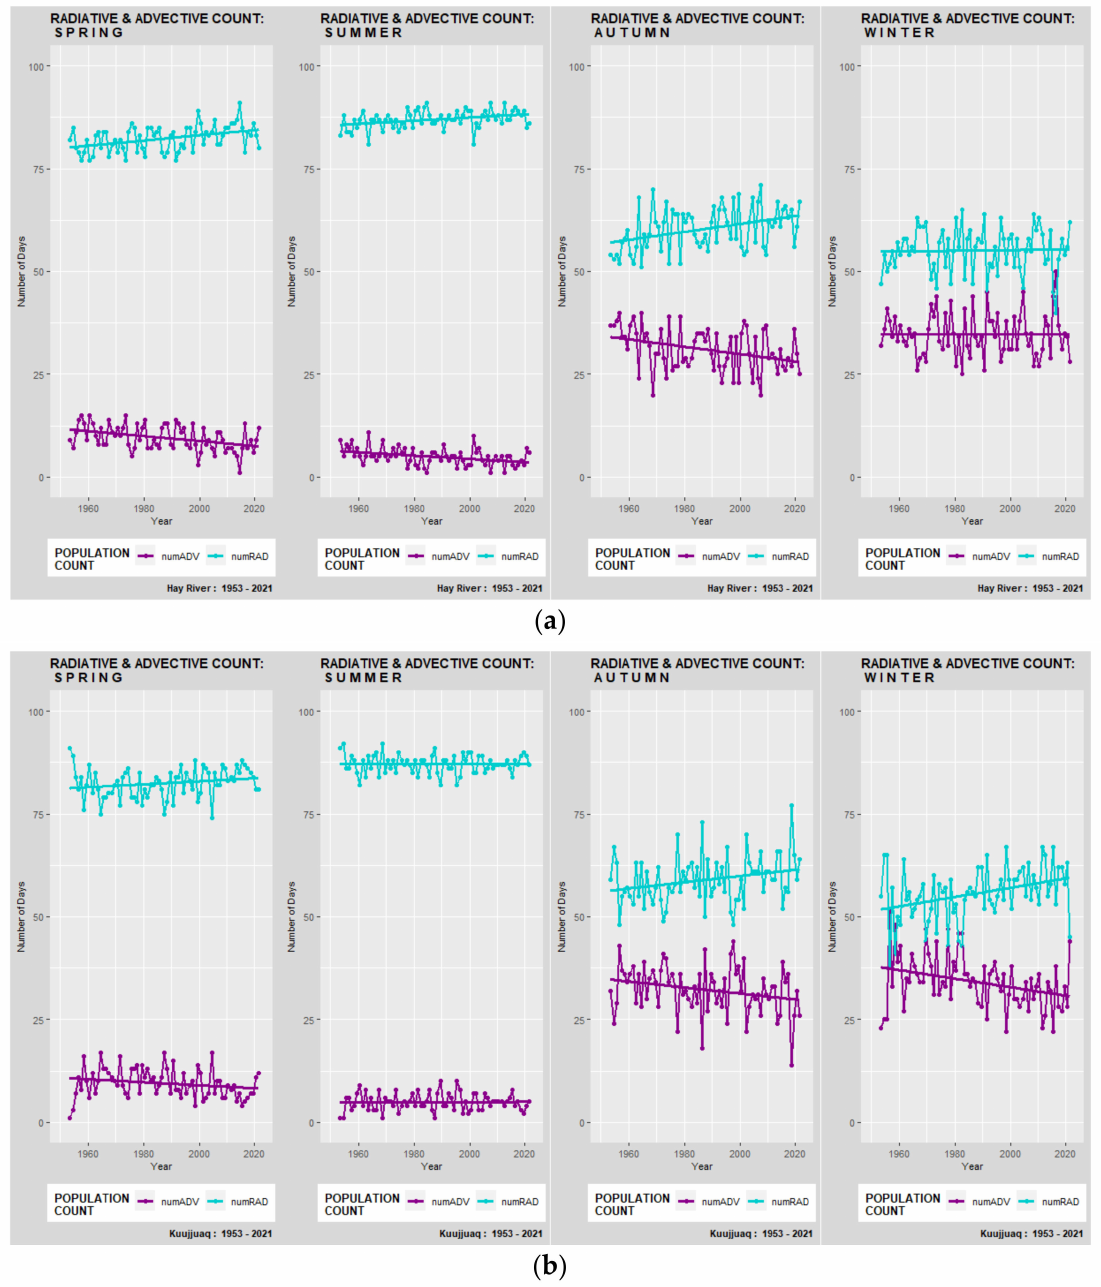
Figure 7. ( a )—Mackenzie District (MCD); Hay River (NT), ( b )—Arctic Tundra (ART); Kuujjuaq (QC). Seasonally averaged radiative and advective temperature population counts, listed in order of Spring, Summer, Autumn, and Winter. ( a )—Radiative Population Count ( RPC ) (cyan blue), and Advective Population Count ( APC )